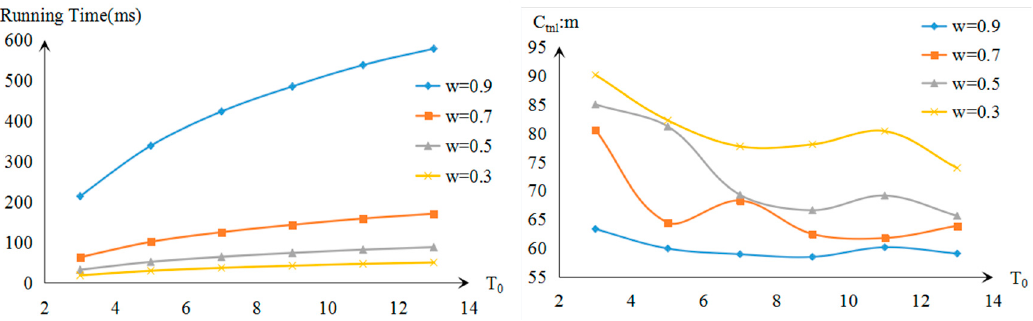
Figure 5. Running time and C tnl values with different annealing speeds w and initial temperatures T 0 .